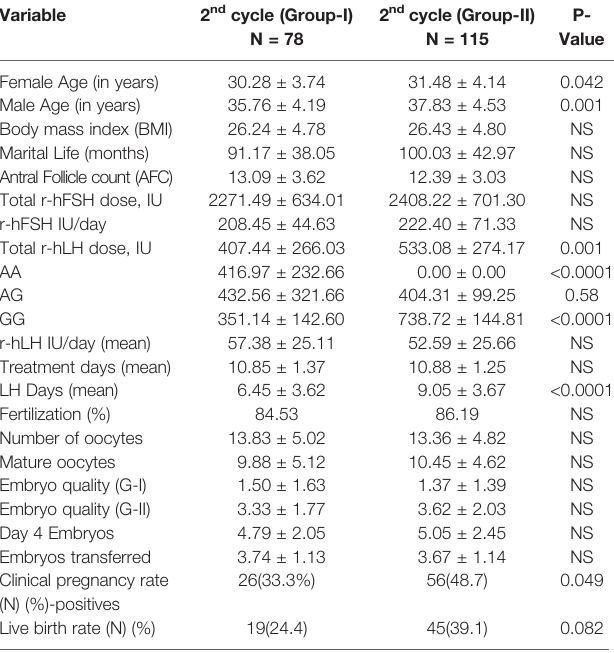
TABLE 2 | Unpaired two sample independent t-test between 2 nd cycle (Group-I) and 2 nd cycle (Group-II).